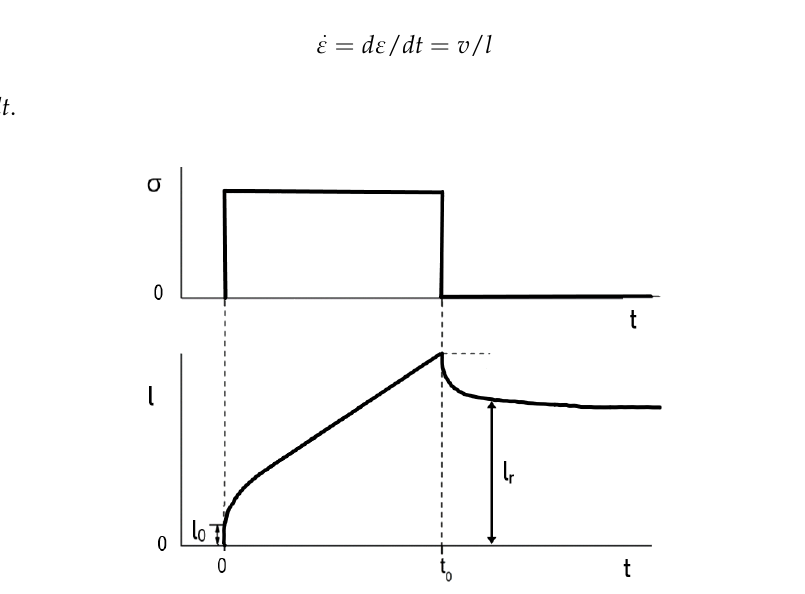
Figure 1. Tensile stress σ and sample length l as functions of experimental time t in a schematic creep recovery experiment on a polymer melt.